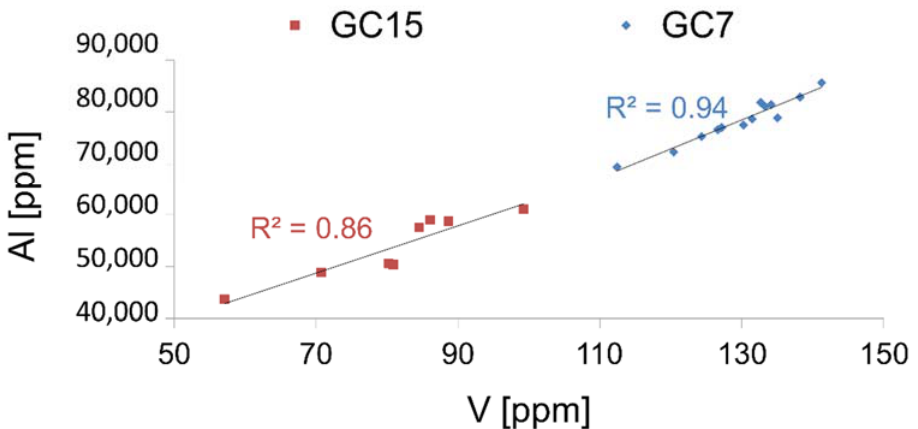
Figure A2. Correlation between aluminium (Al, measured by ICP-OES) and vanadium (V, measured by ICP-MS) contents for the GC7 core (14 samples) and the GC15 core (8 samples).